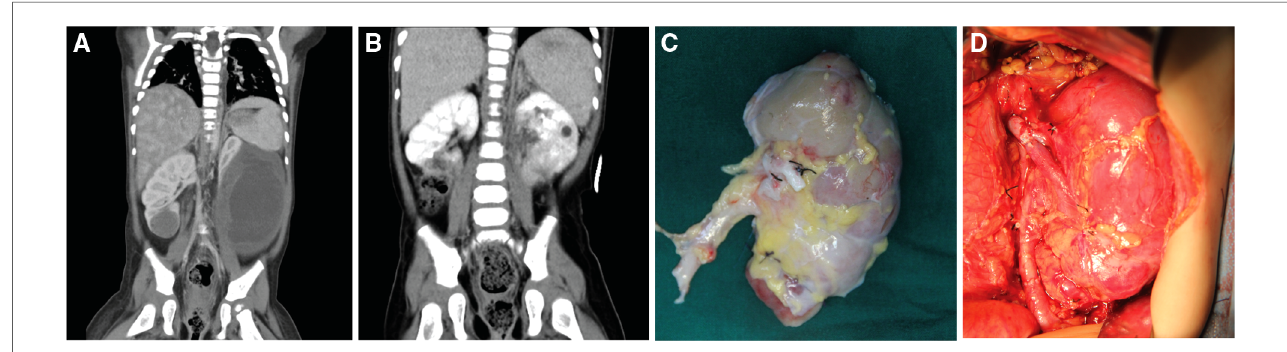
FIGURE 1 Preoperative images of patients and photos of the surgical area. ( A ) The preoperative enhanced CT image of patient No. 8 showed a tumor size of 83×62× 116 mm in the lower pole of the left kidney and a tumor size of 28×23×26 mm in the lower pole of the right kidney; ( B ) The post-operative enhanced CT image of patient No. 8, the renal tumor has been completely resected; ( C ) The left kidney was completely stripped of the tumor in vitro , and the residual kidney was sutured; ( D ) The left kidney was